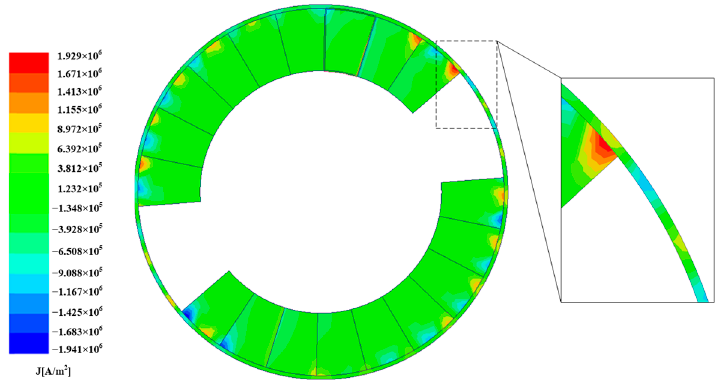
Figure 16. The eddy current density distribution of the 1 mm stainless steel jacket.